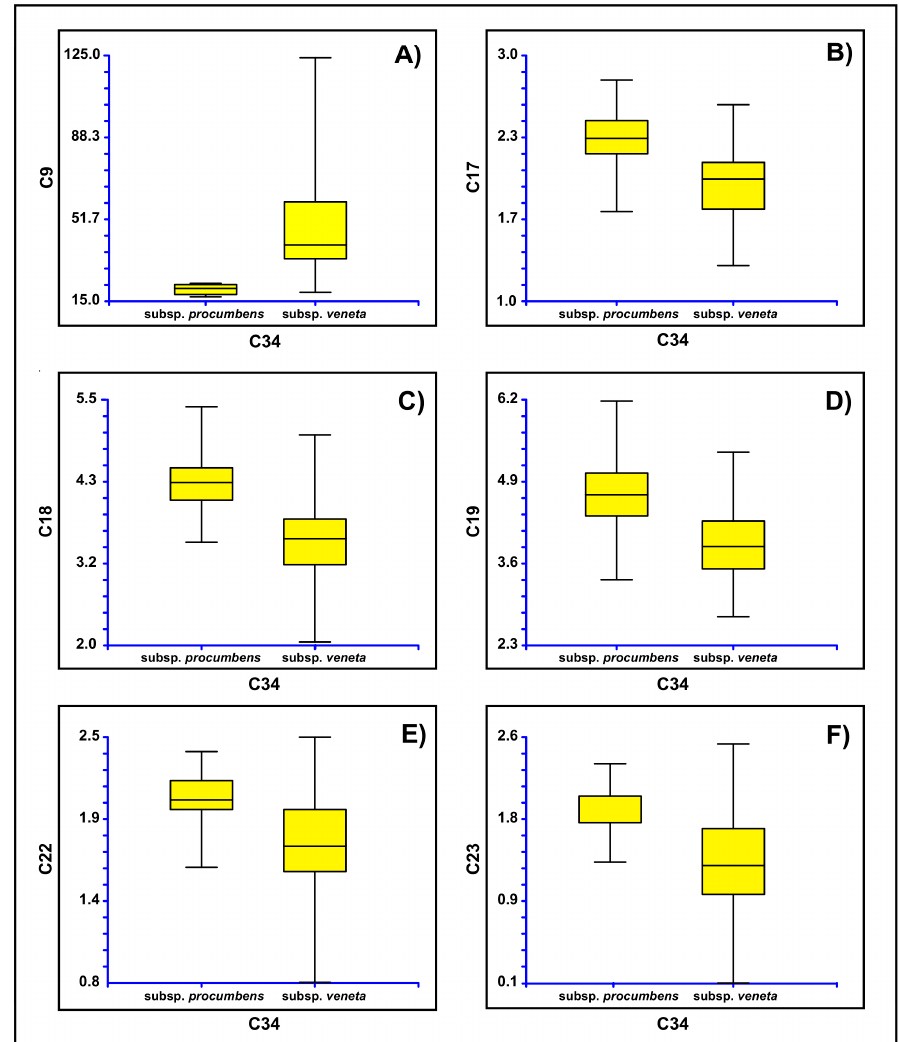
Figure 13. Box plots showing the variability of the diagnostic character for the groups derived from the plastid tree: ( A ) length of the ultimate branch, ( B ) width of the middle flower, ( C ) width of the three flowers, ( D ) minimum width of the second fertile segment, ( E ) height of the middle flower of the third segment, and ( F ) height of the side flower of the third segment.